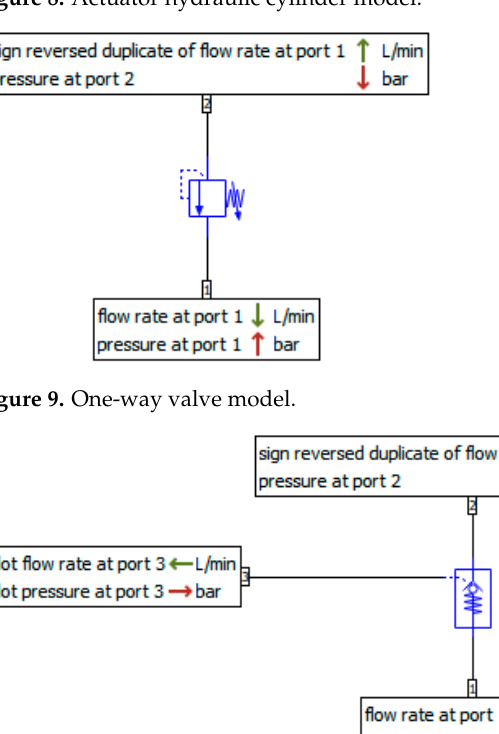
Figure 8. Actuator hydraulic cylinder model.